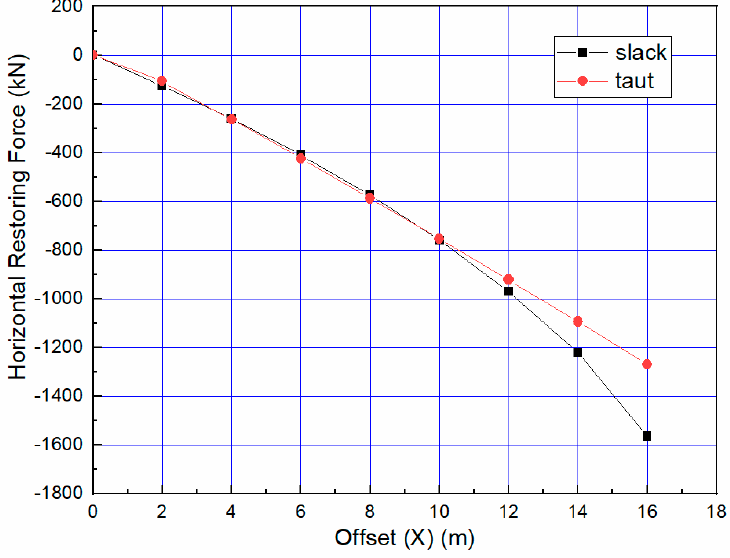
Figure 14. Load o ff set graph in the X Figure 14. Load offset graph in the X direction. Table 5. Taut mooring line properties [43,44].